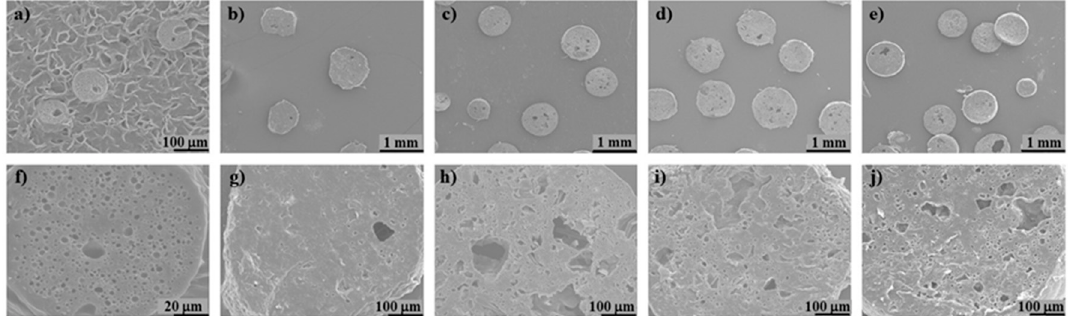
Figure 6. SEM images of the inner structure of biocomposite spheres: ( a , f ) PLA; ( b , g ) PLA/UP; ( c , h )